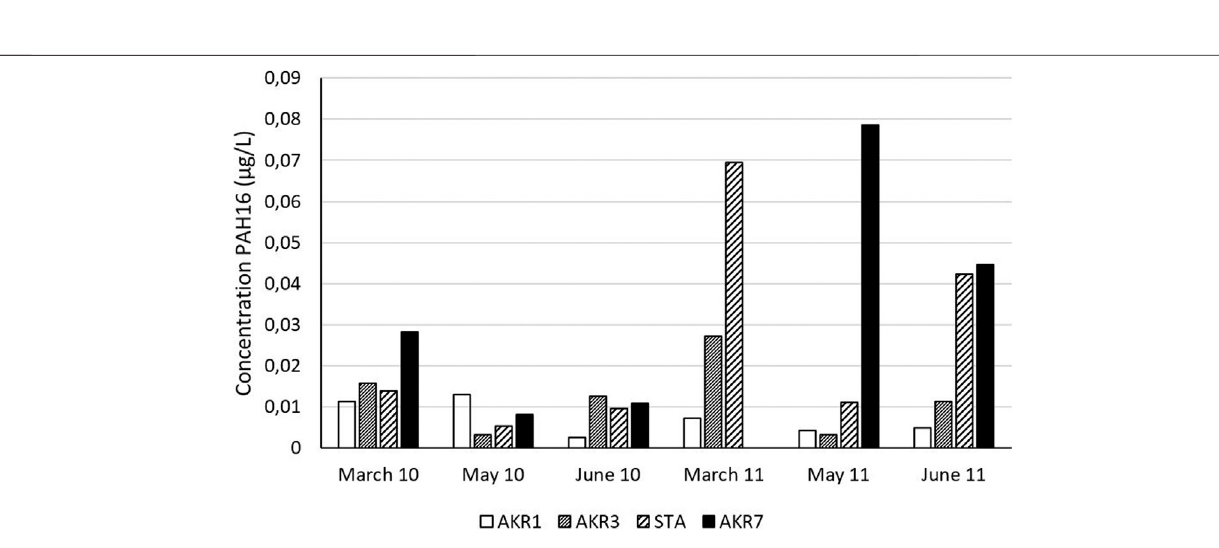
FIGURE 4 | PAH 16 concentrations in the grab samples during the 6 sampling events (sample AKR7 March 2011 was